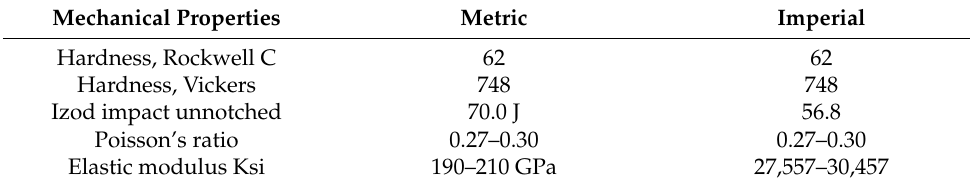
Table 3. Mechanical properties of D2 die steel